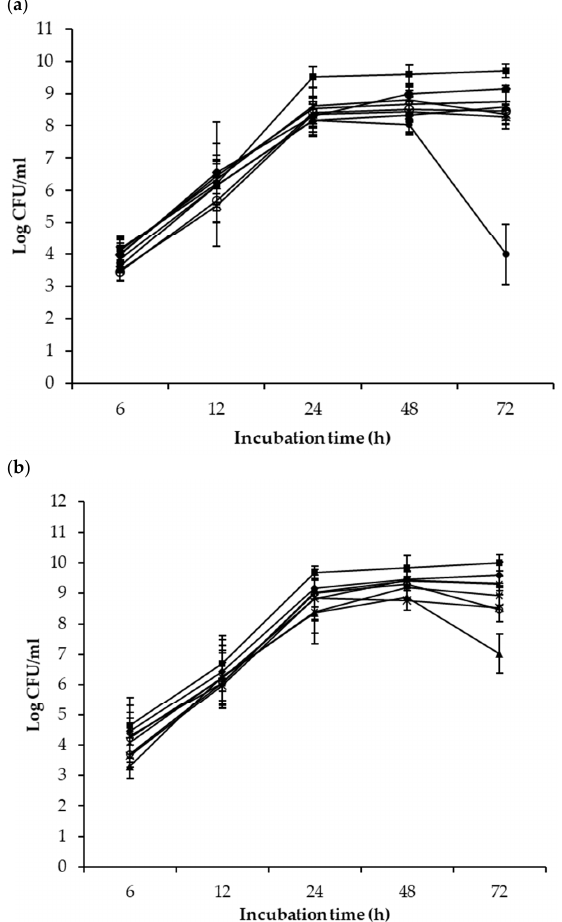
Figure 1. Mean populations of all four strains of S. enterica ( a ) or E. coli ( b ) in the controls ( ) and the mixed cultures with P. fluorescenes A506 ( ), B. subtilis ATCC 6051 ( ), B. mojavensis RRC 101( ), Cocktail 1 ( ), Cocktail 2( ), L. rhamnousus GG ( ) and P. syringae pv. tomato DC3000 ( ) after 6, 12, 24, 48 and 72 h of co-incubation at 25 ° C. The competitiveness of L. rhamnosus GG towards Salmonella and EHEC growth was much stronger at 37 °C compared to 25 °C (Figure 2). After 24 h of co-incubation with L. rhamnosus GG, the mean populations of all four tested Salmonella or EHEC strains were lower at 37 °C than at 25 °C. No Salmonella cells were detected from the co-culture with L. rhamnosus GG at 37 °C after the 48-h sampling point (detection limit: 10 CFU/mL). The mean populations of EHEC recovered from the co-cultures with L. rhamnosus GG were relatively higher than those of Salmonella incubated at the same temperatures.